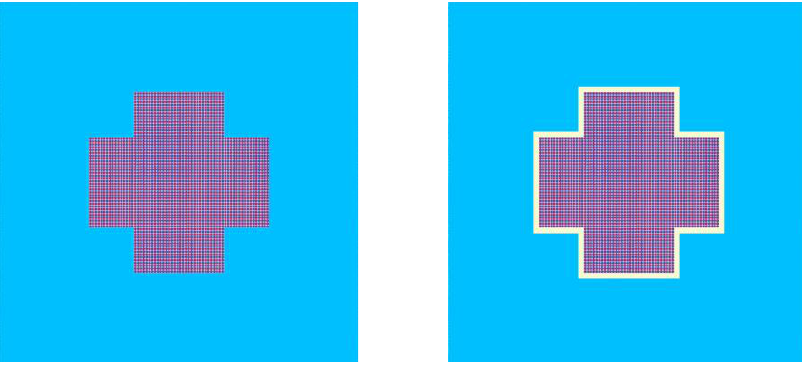
Figure 5. CASMO5 multi-assembly depiction of DIMPLE S06A (left) and S06B (right).